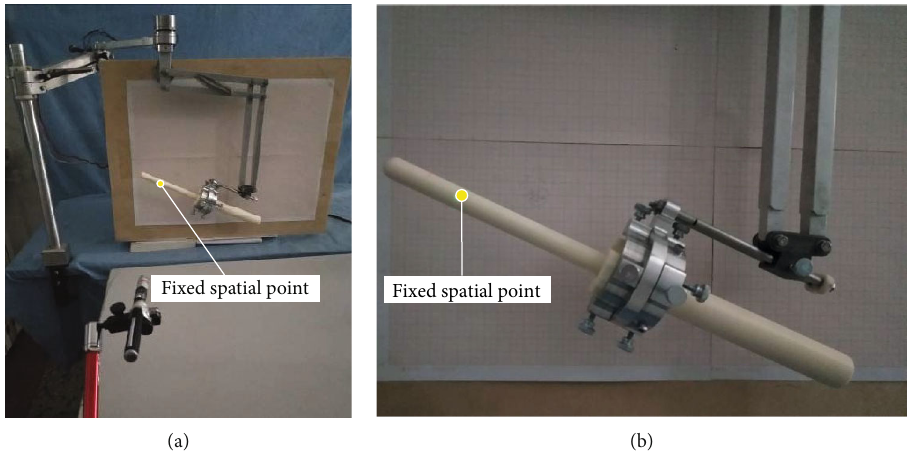
Figure 15: Measurement of pitching center point error: (a) overall view; (b) partial magni fi cation view.